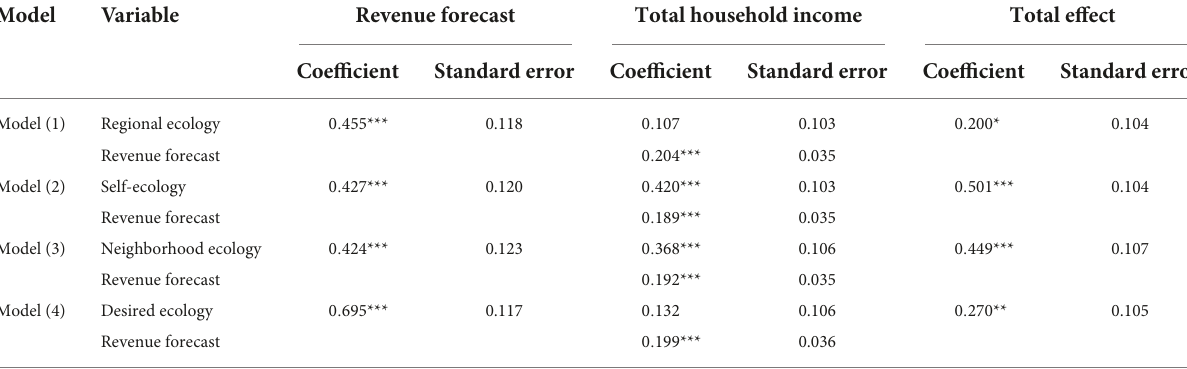
TABLE 6 Effects of ecological aspirations on total household